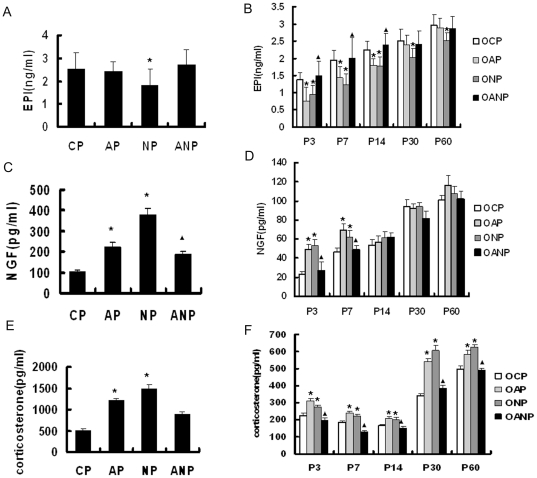
Serum levels of EPI, NGF and corticosterone in rats.
A: Serum levels of EPI decreased significantly in NP rats
compared to CP rats. B: Serum levels of EPI decreased in
OAP rats from P3 to P14 compared to OCP rats and regained normal level
from P30 to P60; however, in ONP rats, from P3 to P60, serum levels of
EPI were lower than those in OCP rats; there is significant increase in
OANP rats compared to OAP rats from P3 to P14. C: Serum
levels of NGF were significantly increased in AP and NP rats compared to
CP rats. Serum NGF levels decreased in ANP rats compared with OAP rats.
D: Compared to OCP rats, serum levels of NGF increased
from P3 to P7 in OAP and ONP rats and regained normal level from P14 to
P60. Compared with OAP rats, serum NGF levels in OANP rats were lower
from P3 to P7 and no significant difference from P14 to P60.
E: Serum levels corticosterone increased in AP and NP
rats compared to CP rats, while ANP rats showed a decline tendency
compared to AP rats. F: Serum levels of corticosterone in
OAP and ONP rats increased significantly compared to OCP rats from P3 to
P60, while those in OANP rats were lower compared to OAP. Values are
expressed as mean ±SEM(n = 8); *
P<0.05 vs CP/OCP, ▴P<0.05 vs AP/OAP.